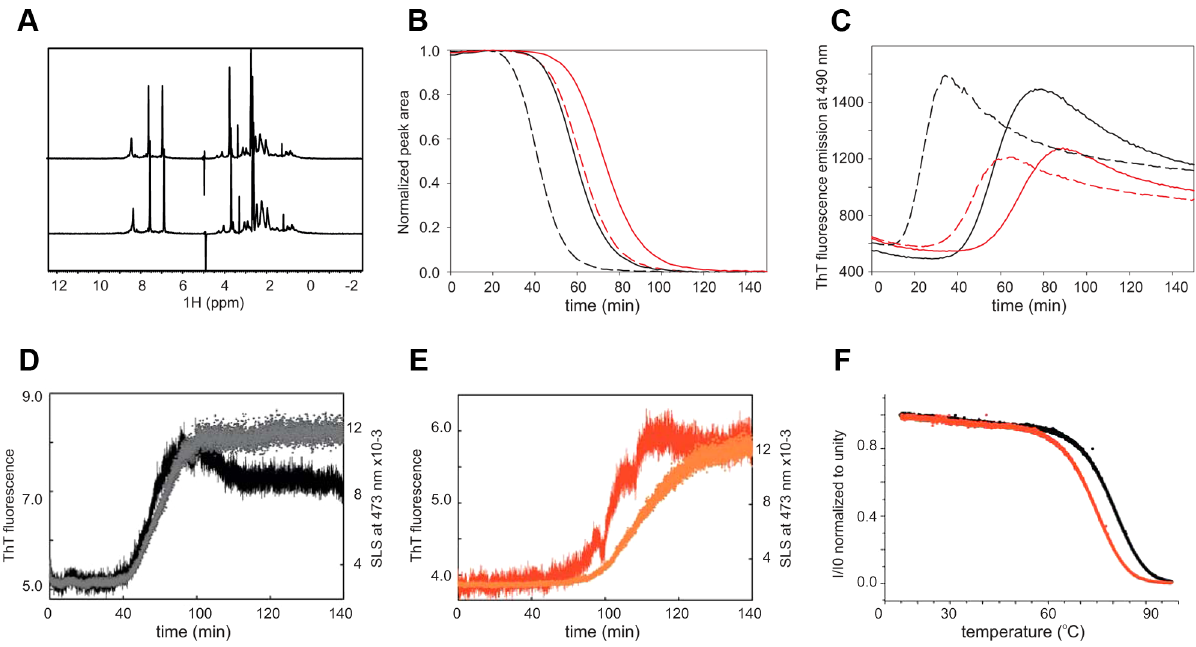
Figure 5. Comparison of the structural and aggregation properties of interrupted and uninterrupted polyQ. ( A ) 1 H NMR spectra of interrupted (upper trace) and uninterrupted (lower trace) of the GST fused polyQ41 and polyQ41H peptides recorded at 600 MHz and 10 u C on 50 m M protein samples in 50 mM sodium phosphate at pH 6.9 and 3 mM DTT. ( B ) Aggregation kinetics followed by NMR collected forpolyQ41 (black) and polyQ41H (red). Continuous and broken lines are used for filtered and non-filtered samples respectively. ( C ) Aggregation kinetics obtained by ThT fluorescence detection at 25 u C in a stirring plate reader. The conventions are the same as in ( B ). ( D ) Simultaneous recording of the SLS, plotting the absorbance at 473 nm (black), coupled with ThT fluorescence aggregation kinetics (grey) for polyQ41. ( E ) The same as in ( D ) for polyQ41H (in red and orange respectively). The measurements were carried out at 37 u C. ( F ) Plot of the light scattering intensity as a function of temperature for polyQ41 (black) and polyQ41H (red).